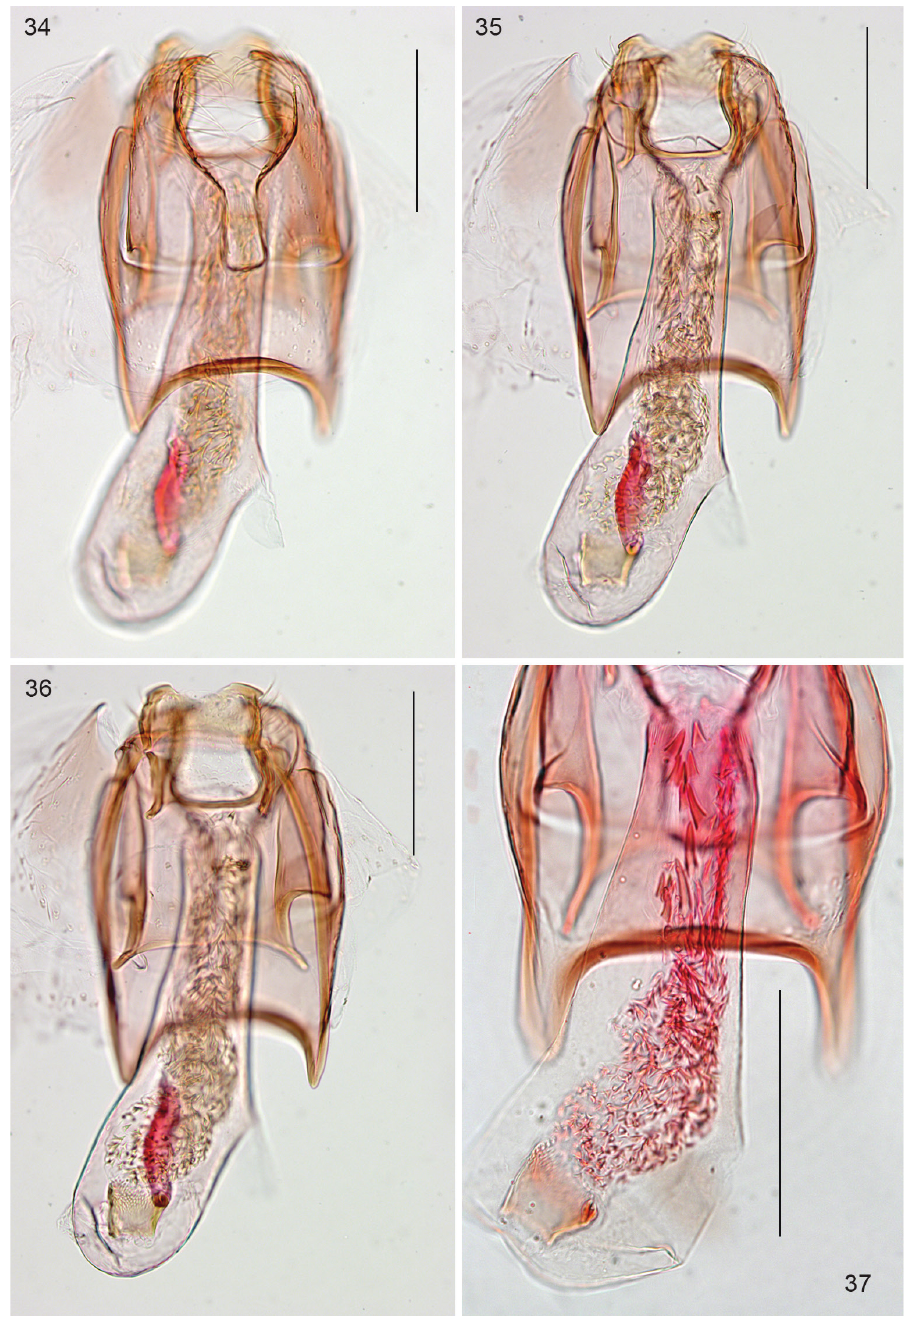
Figures 34–37. Stigmella schinivora , male genitalia. 34–36 Holotype, slide EvN3986, in different levels of focus 37 Detail of cornuti in phallus, slide EvN4500. Scale bars: 100